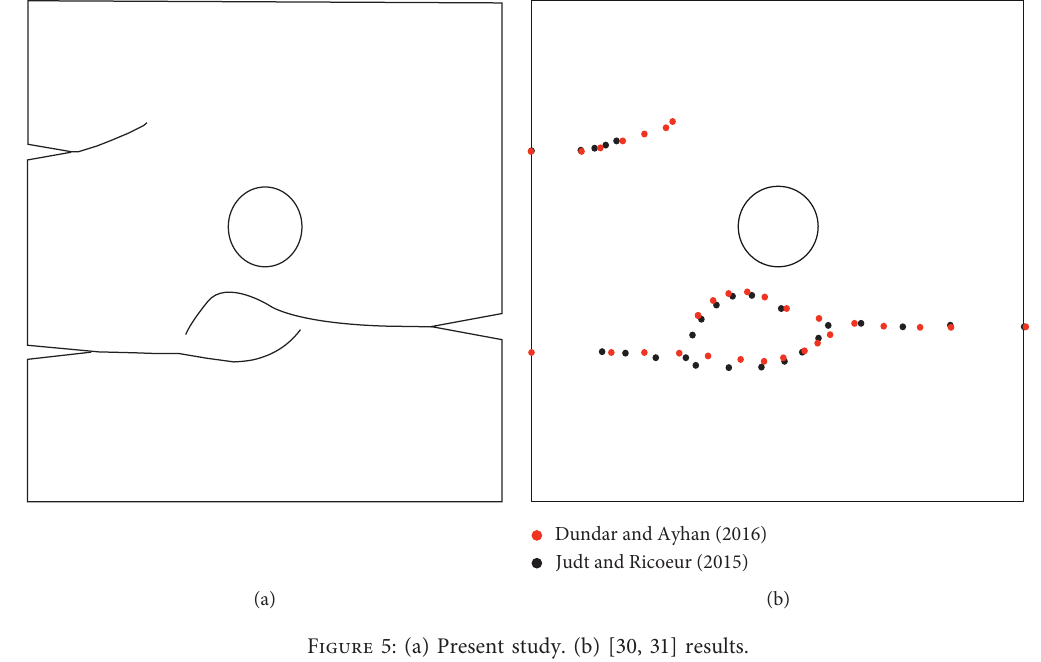
Figure 5: (a) Present study. (b) [30, 31] results.